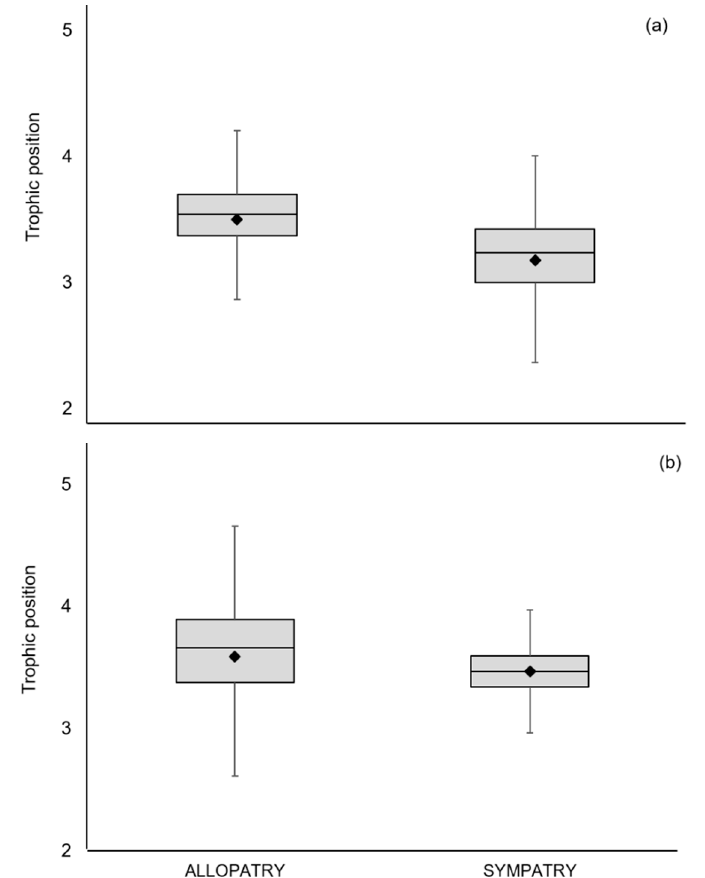
Figure 4. Estimates of trophic position of the ( a ) European mink and ( b ) American mink in allopatry and sympatry. Bars show the median and mean (diamond) trophic position and 95% credibility intervals, calculated relative to a baseline using tRophicPosition.